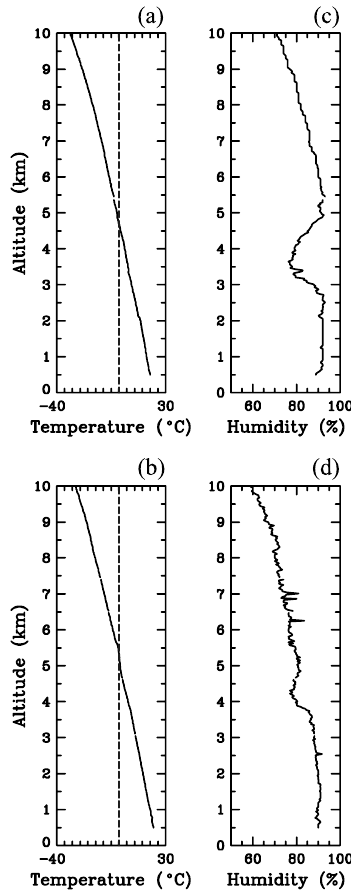
Fig. 9. Radius-height cross section of (a) radial and (b) tangential winds obtained by the MU radar and the L-band BLR before the passage of the typhoon center at an interval of 6 min. The height interval of the MU radar and the BLR is 150 m and 100 m, respec- tively. Positive and negative values of radial wind indicate inflow and outflow, respectively. Positive values of tangential wind indi- cate counterclockwise winds.